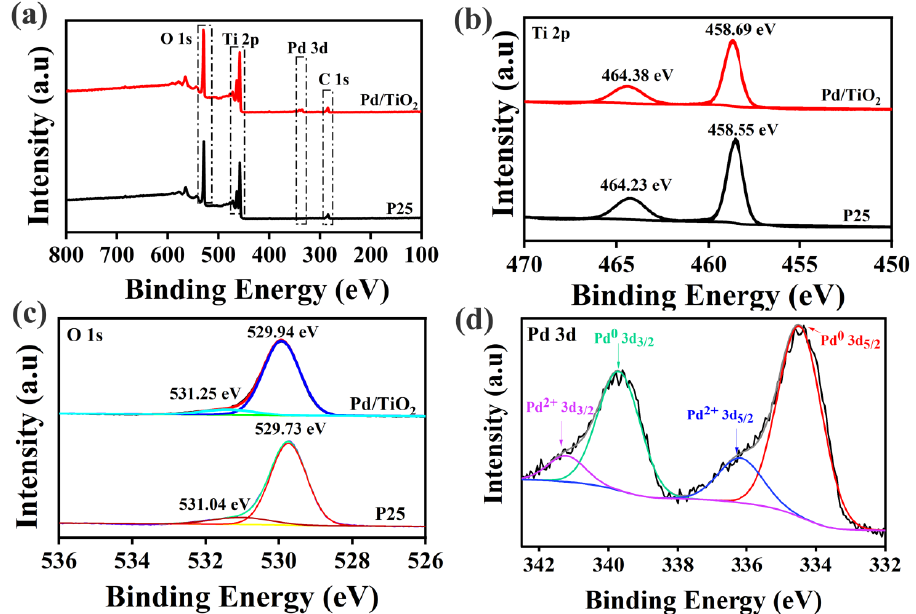
Figure 4. ( a ) XPS survey spectrum and core-level spectra of ( b ) Ti 2p, ( c ) O 1s and ( d ) Pd 3d.